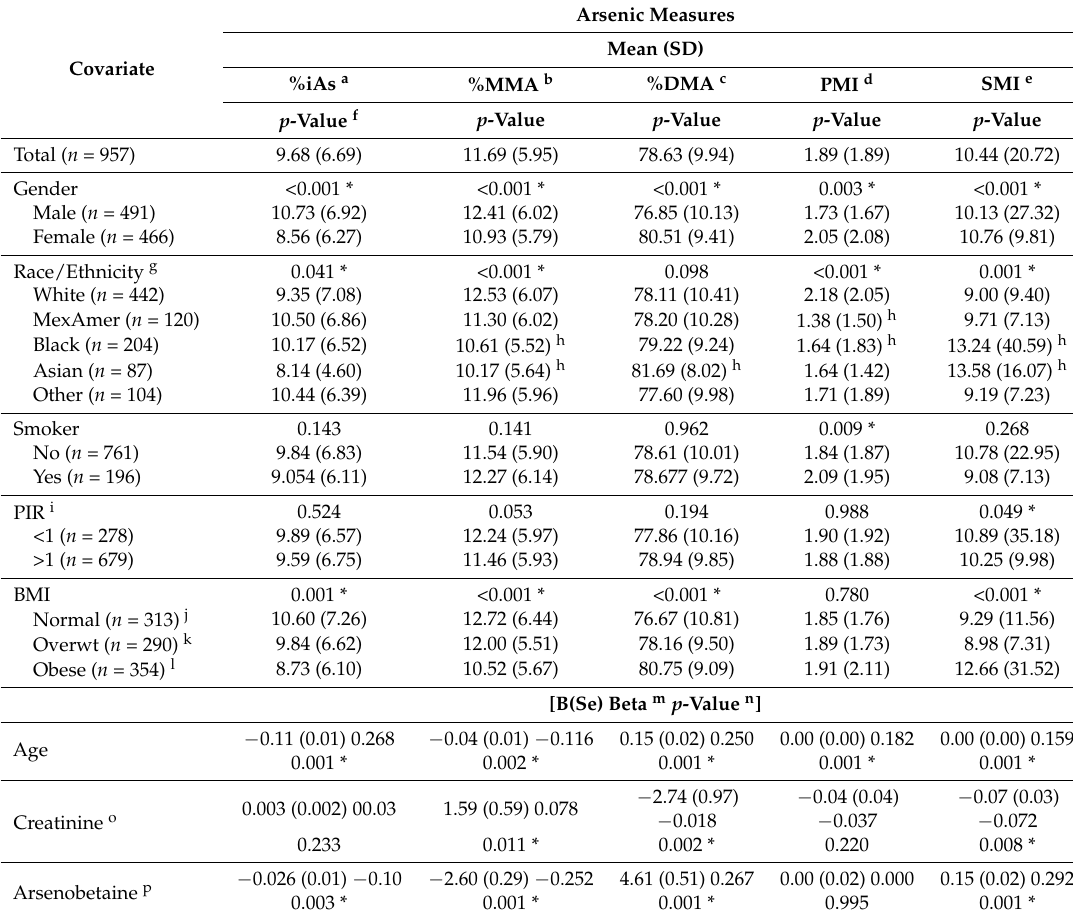
Table 2. Distribution of arsenic measures by